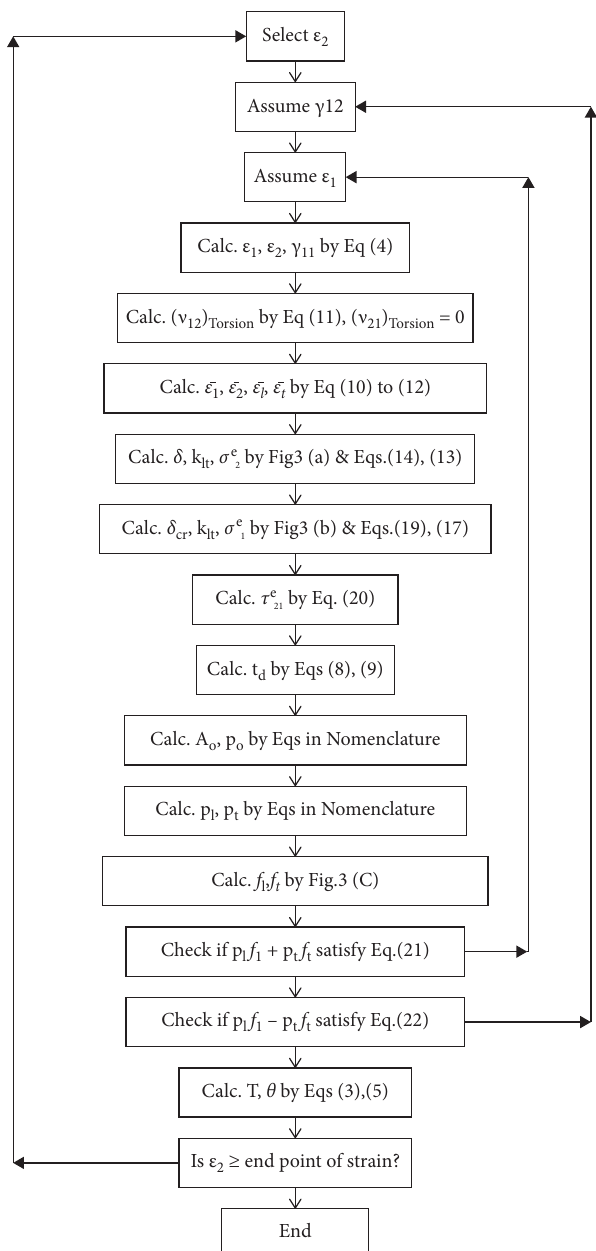
Figure 4: Solution algorithm for the SMMT.